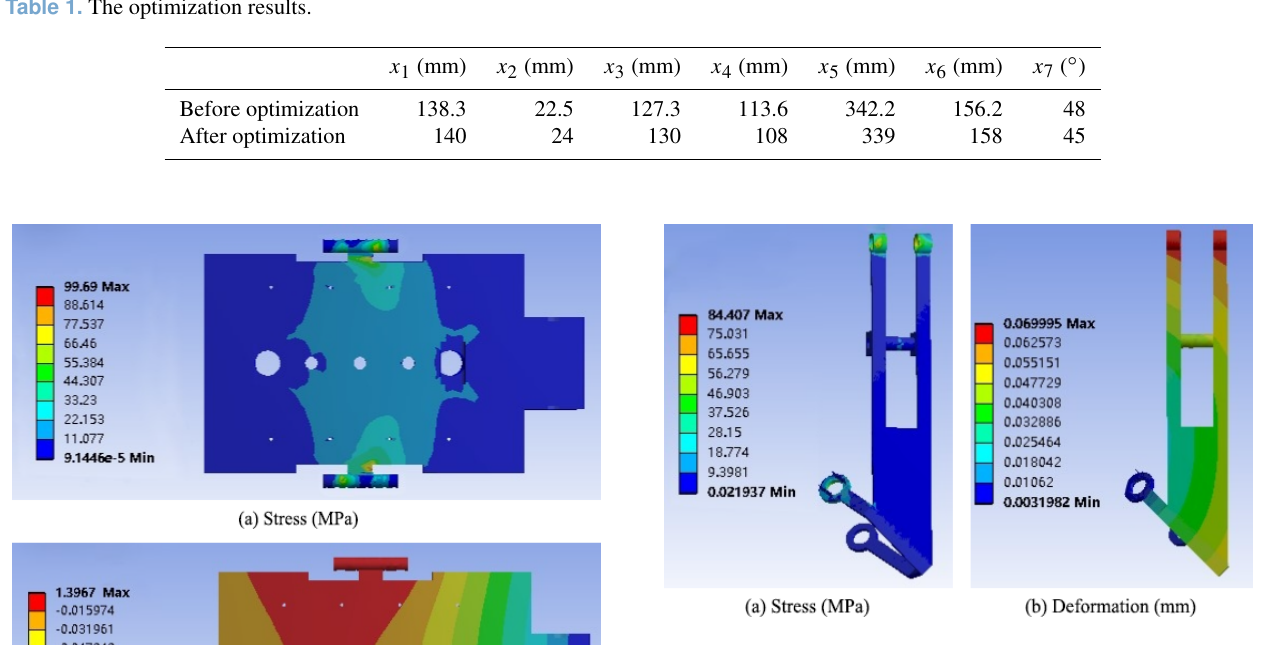
Figure 7. The cloud diagrams of the stress and deformation of the front-frame clamping